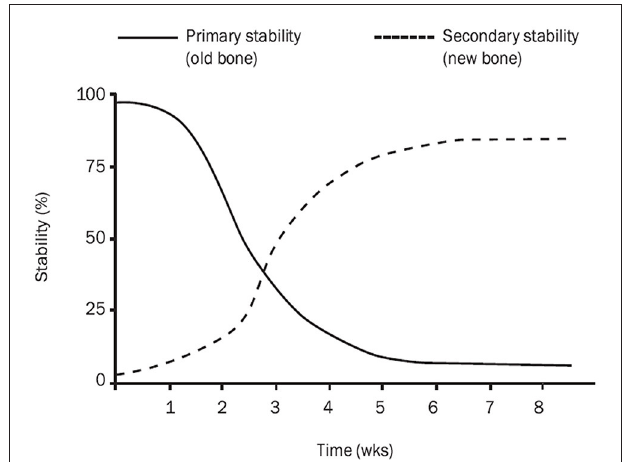
FIGURE 1 | Implant stability in the bone. The graph presents gradual changes in primary (mechanical) and secondary (biological) stability of an implant placed in the bone. Primary and secondary stability influence on total implant stability. There is a decrease in total stability between 2 and 4 weeks after implantation. Graph imported from Raghavendra et al. (